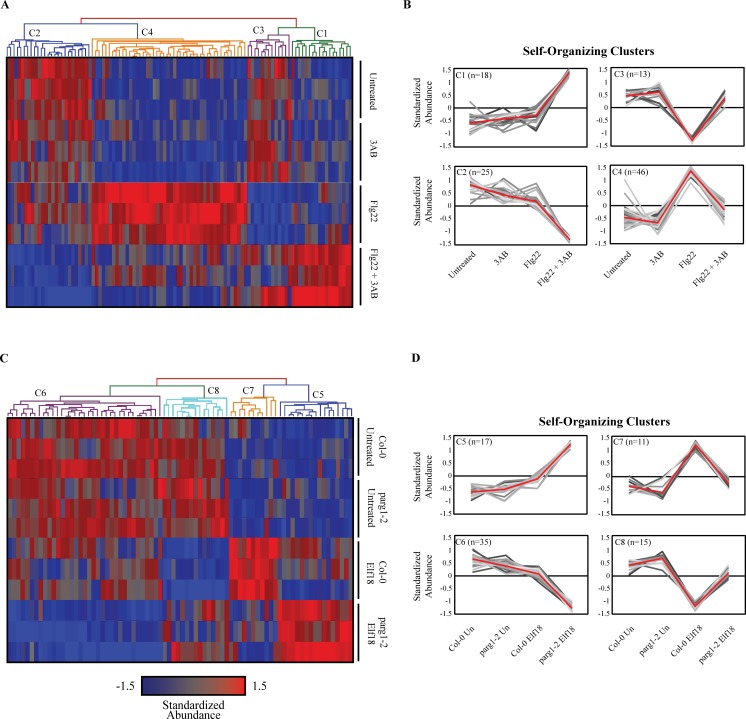
Hierarchical clustering of gene products whose regulation by MAMPs are broken or misregulated by PARP inhibitor or parg1-2 knockout.A, C, Hierarchical clustering of transcript abundance for MAMP-regulated genes identified (see Fig 3) as exhibiting broken or misregulated expression due to 3AB treatment (A, n = 102) or due to parg1-2 mutation (C, n = 78). Each column represents a single gene and each row a single treatment (all treatments replicated three times); gene abundances standardized to mean = 0, standard deviation = 1.0; red = more abundant, blue = less abundant. Clustering was performed by calculating Euclidean distances on columns, using average linkage scores. B, D, Average transcript abundance (y-axis) for each treatment (x-axis), for each gene within the designated color-coded clusters shown at the top of A and C. Red lines denote overall mean mRNA abundance for all genes within the cluster, and grayscale lines represent each individual gene within the cluster.